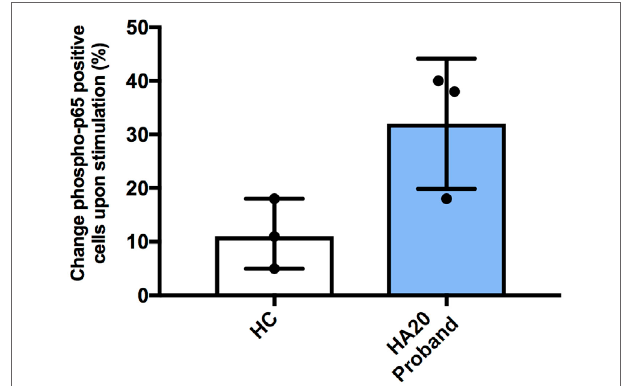
FIGURe 2 | Increased NF- κ B phospho-p65 response in A20 haploinsufficiency. The difference in percentage change of cells positive for CD14 and phospho-p65 from unstimulated to stimulated, for healthy controls and A20 proband. Representing three independent experiments. Phosflow with PBMCs were stimulated for 15 min at 37°C with 100 ng/mL LPS (Invivogen, UK). BD Phosflow Fixing and BD Phosflow Perm Buffer III (BD Biosciences) were used in combination with aqua dye Live/Dead Fixable cell stain kit (Invitrogen, UK). Antibodies: CD19 BV421 (Cat No. 562440—clone HIB19); CD3 FITC (Cat No. 555332—clone UCHT1); CD14 AF700 (Cat No. 557923—clone M5E2); CD4 APC-Cy7 (Cat No. 341115—clone